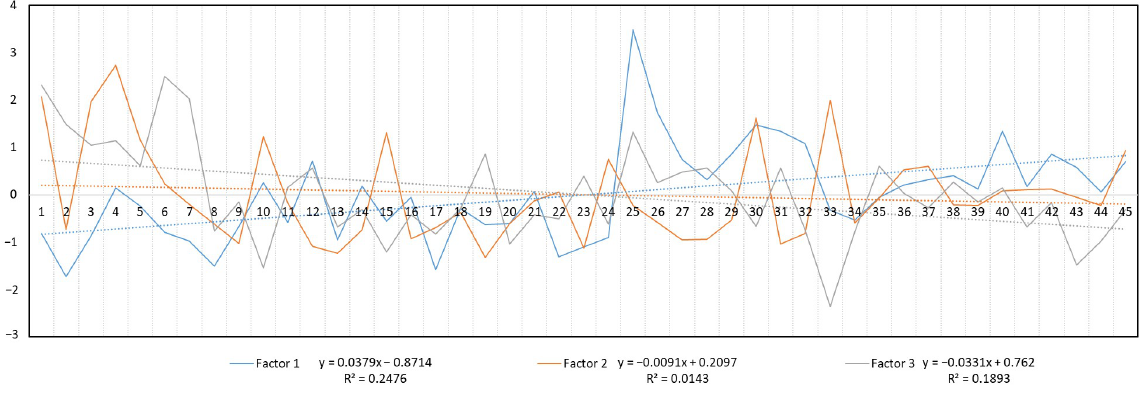
Figure 6. Factor scores in research points.